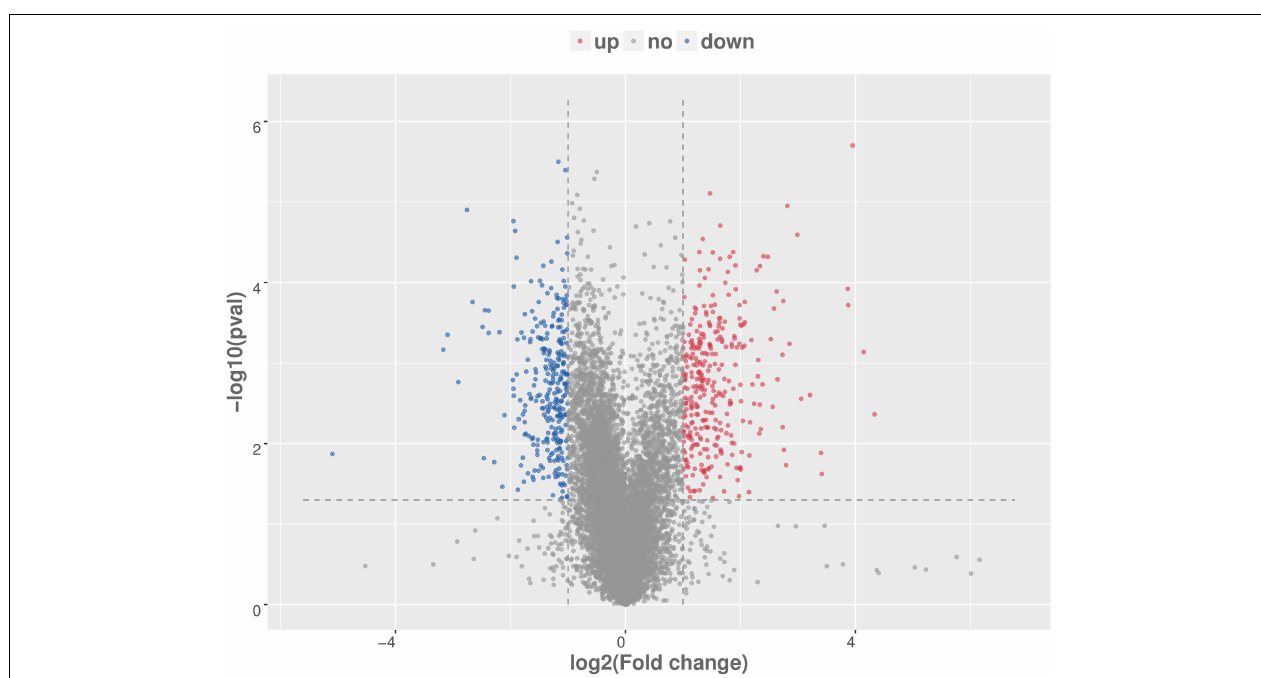
FIGURE 4 | Volcanic map analysis of differential gene expression level. A scatter plot shows the correlation of gene abundance. The red dot, blue dot, and gray dot signify upregulation, downregulation, and not different,